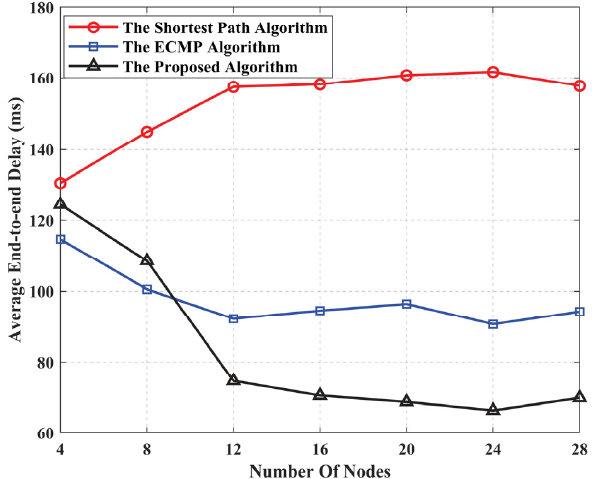
Figure 10. Average end-to-end delay at di ff erent topology sizes.